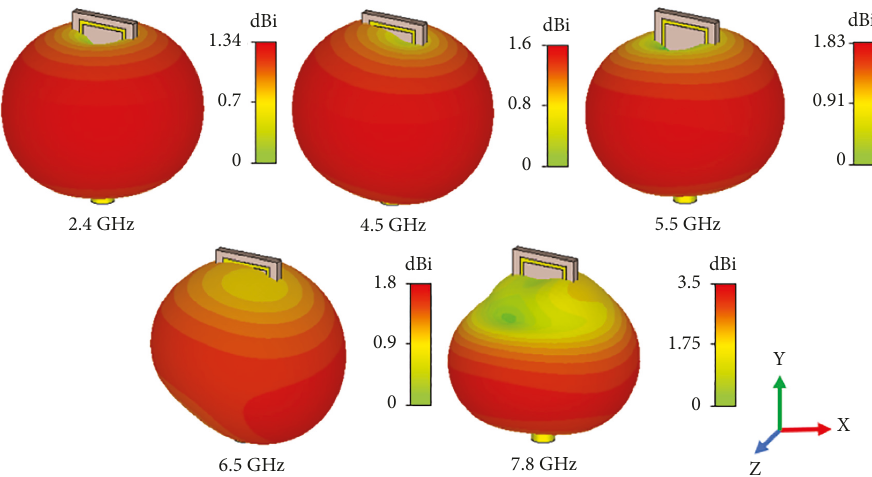
Figure 9: Simulated 3D radiation